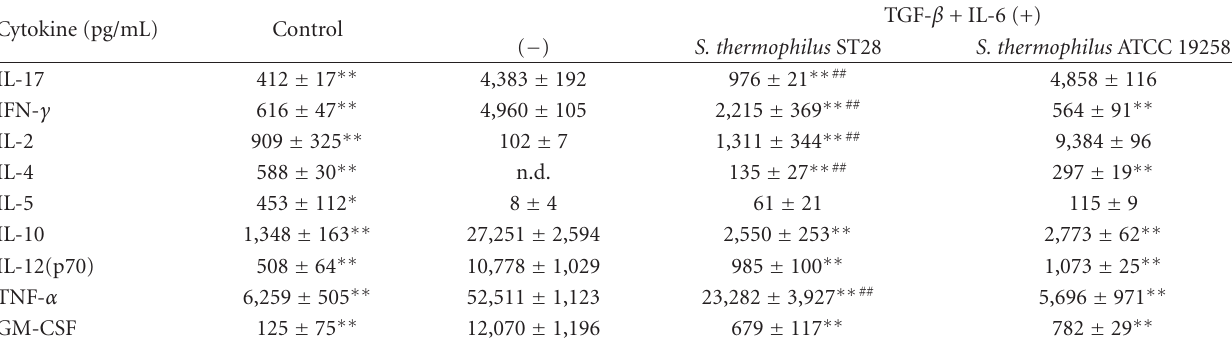
Table 1: Changes in cytokine production patterns by murine splenocytes in Th17-skewed conditions by the addition of S. thermophilus ST28 or S. thermophilus ATCC 19258.